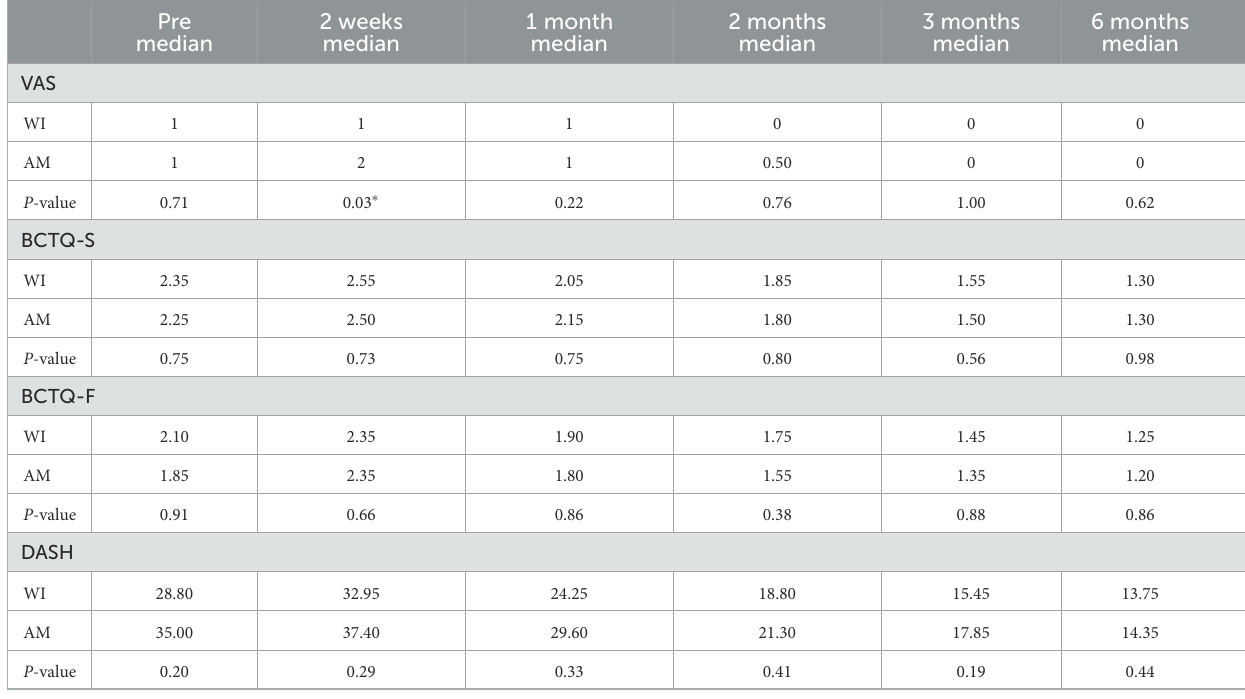
TABLE 4 Outcome measures of VAS and self-evaluation.